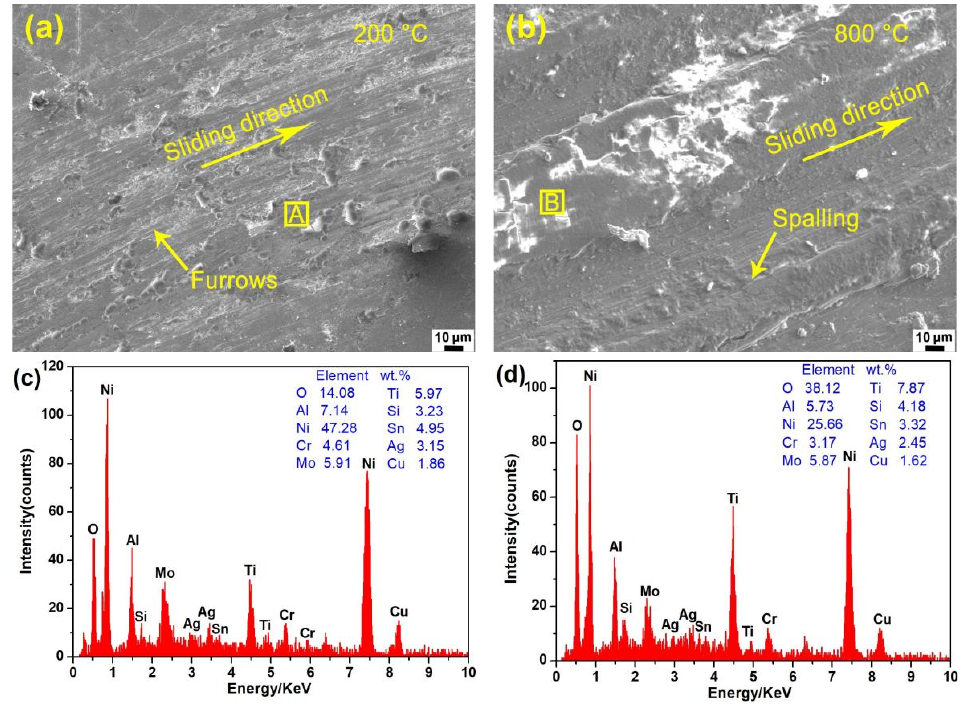
Figure 8. ( a , b ) Worn surface morphologies of NST at 200 and 800 °C; EDS results of the box labeled areas: ( c ) position A and ( d ) position B.